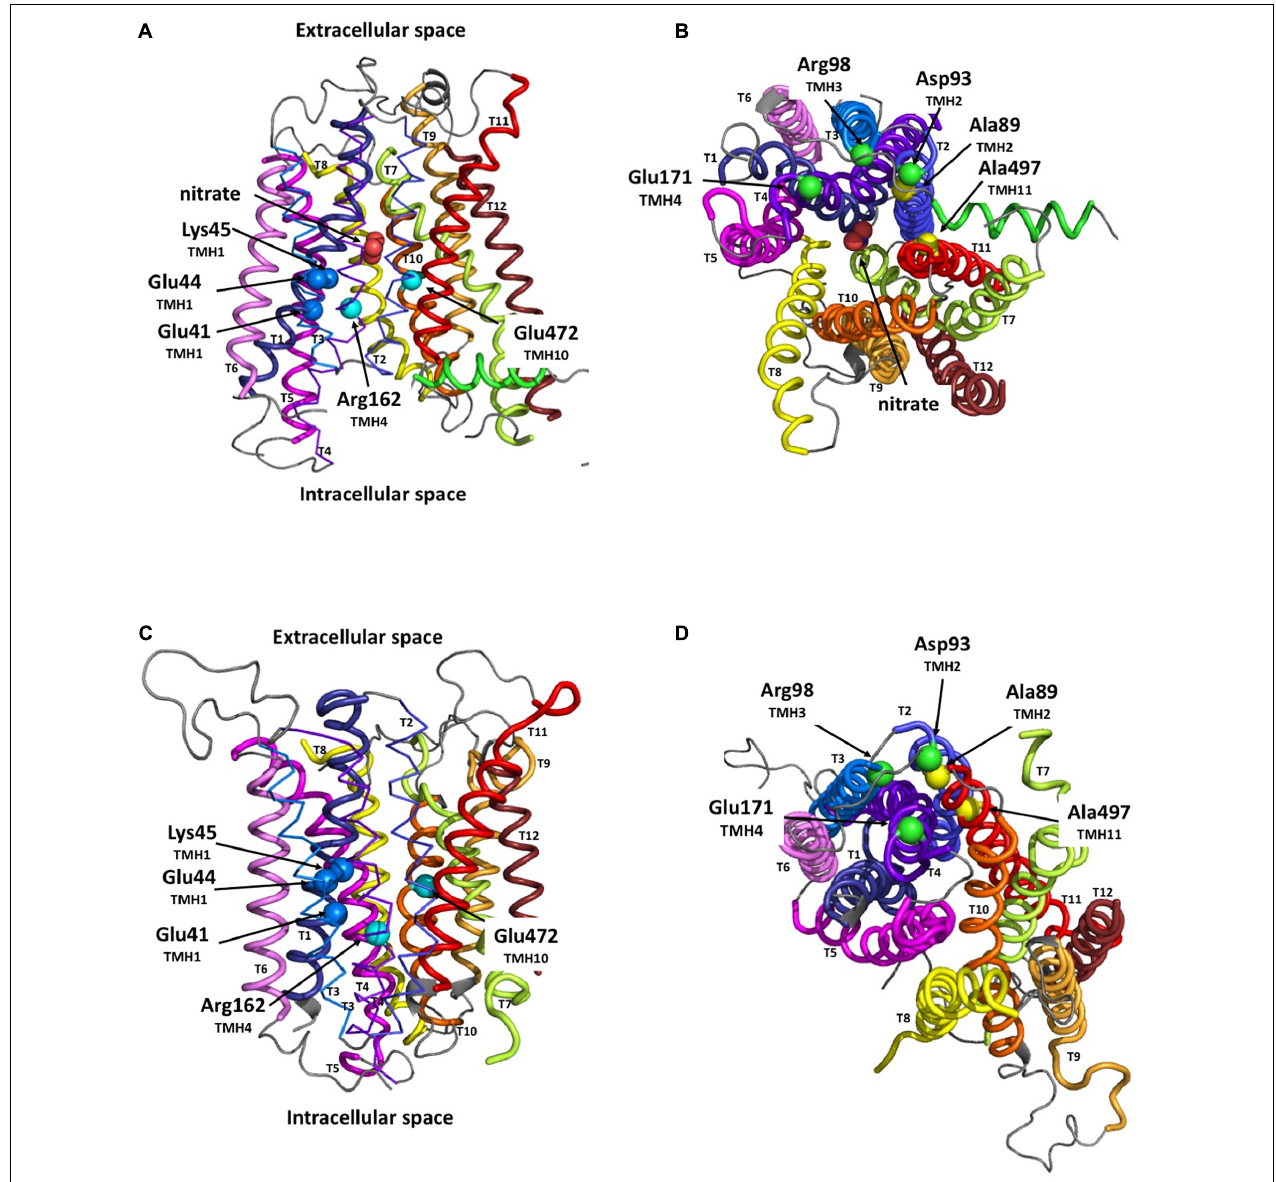
FIGURE 1 | Structural models of MtNPF1.7 in two different conformations. Loop rendering of the peptide backbone of the in silico models of MtNPF1.7. Templates for homology modeling were the crystal structures of AtNPF6.3 for the inward-open (I o ) conformation (pdb: 4oh3) (Sun et al., 2014) in panels (A,B) and of E. coli YajR for the outward-open (O o ) conformation (pdb: 3wdo) (Jiang et al., 2013) in panels (C,D) . Important residues are shown as spheres corresponding to their C α atoms. (A,C) MtNPF1.7 models as viewed from the membrane with the ExxE(R/K) motif residues Glu41, Glu44, and Lys45 as dark blue spheres, and two residues, Arg162 and Glu472 predicted to form a TMH4-TMH10 salt bridge in the O o conformation as cyan spheres. (B,D) 90 ◦ rotation of panels (A,C) for a view from the cytoplasmic side of the membrane with residues involved in the salt-bridge triad, Asp93, Arg98, and Glu171, as green spheres, and residues important for packing in the O o conformation, Ala89 and Ala497, as yellow